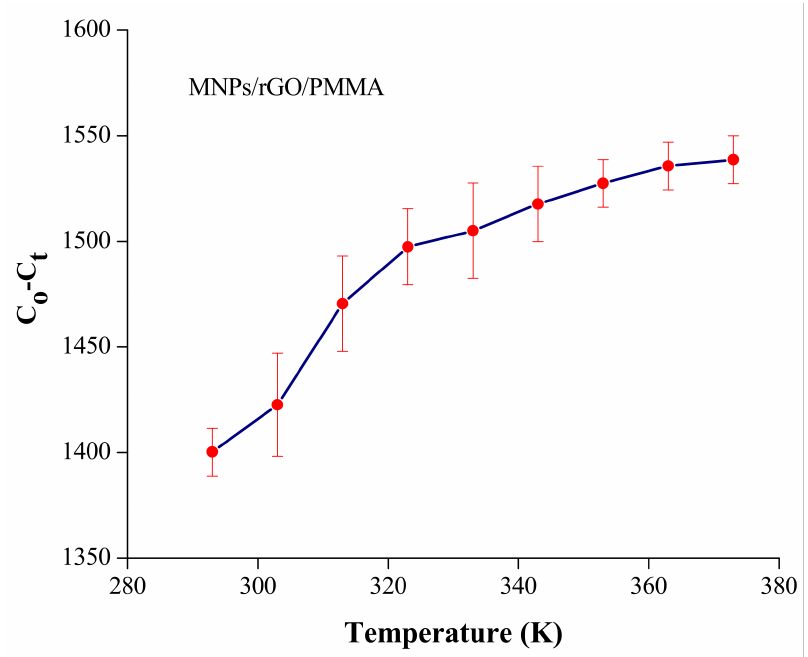
Figure 7. Effect of temperature on adsorption of Cr(VI) on MNPs/rGO/PMMA composite; adsorbent amount, 150 mg; shacking time, 30 min; pH